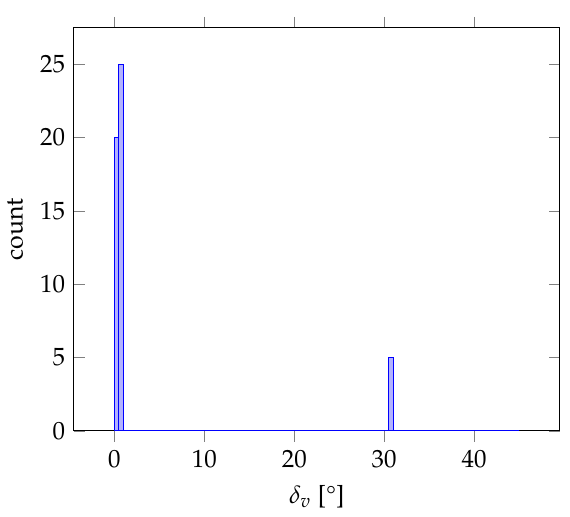
Figure 16. Histogram of the 50 δ v values resulting in the mean value of 3.54° ± 23.86° presented in Table 1 for the triangle mesh “Attic” depicted in Figure 12c. Without the 5 outliers around 31°, the mean δ v results in 0.50° ±